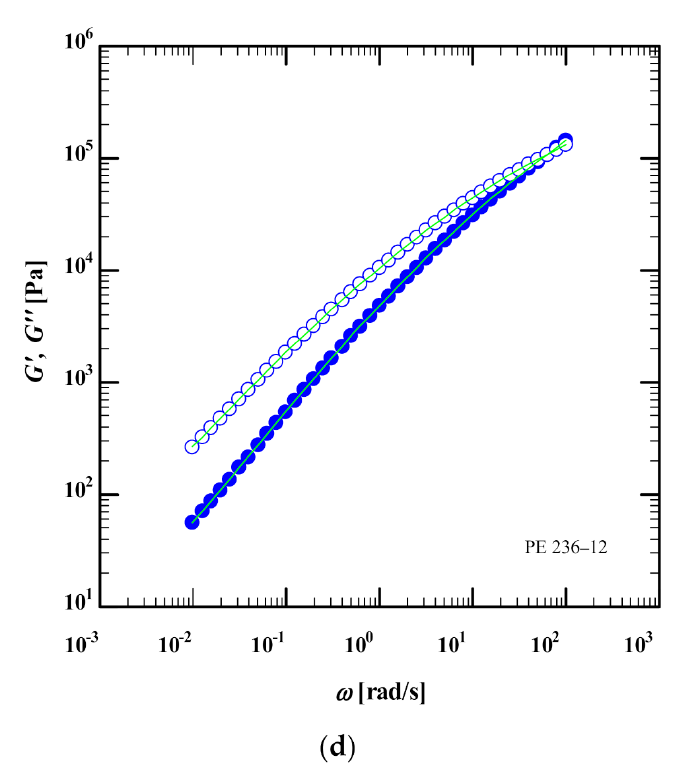
Figure 1. Storage ( G (cid:48) ) and loss ( G (cid:48)(cid:48) ) moduli of ( a ) PE 191-8, ( b ) PE 127-9, ( c ) PE 124-10 and ( d ) PE 236-12 at 160 ◦ C (symbols) digitized from Morelly and Alvarez [23]. Continuous green lines represent fit by discrete relaxation spectrum (Equation (1) and Table 1) using the IRIS software [32].